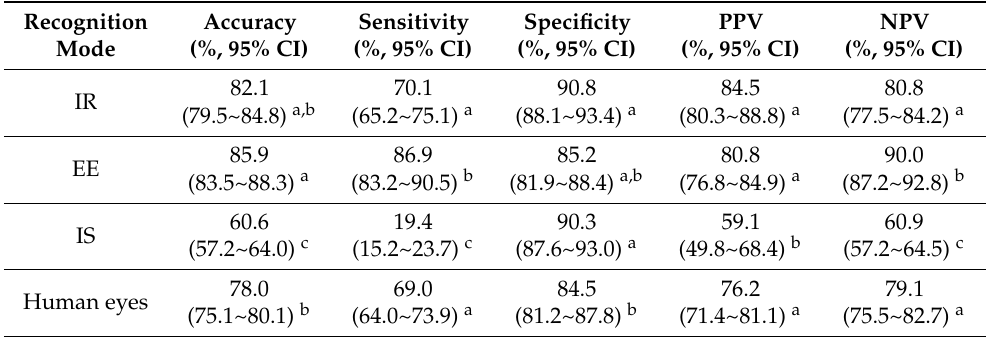
Table 2. Accuracy, sensitivity, specificity, PPV, and NPV for the detection of proximal caries using different recognition modes and human